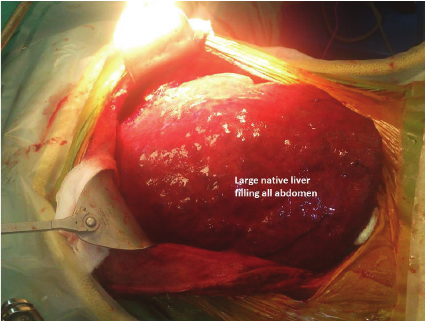
Figure 2: Large native liver filling the entire abdomen is seen. Figure 3: The view after diaphragm resection and the anastomosis between right atrium and first part of cadaveric aortic graft is